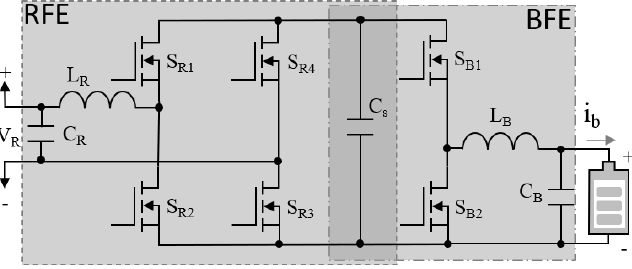
Figure 8. Schematic circuit of the local converter power hardware. Table 4. Power component details for the two stage DC–DC